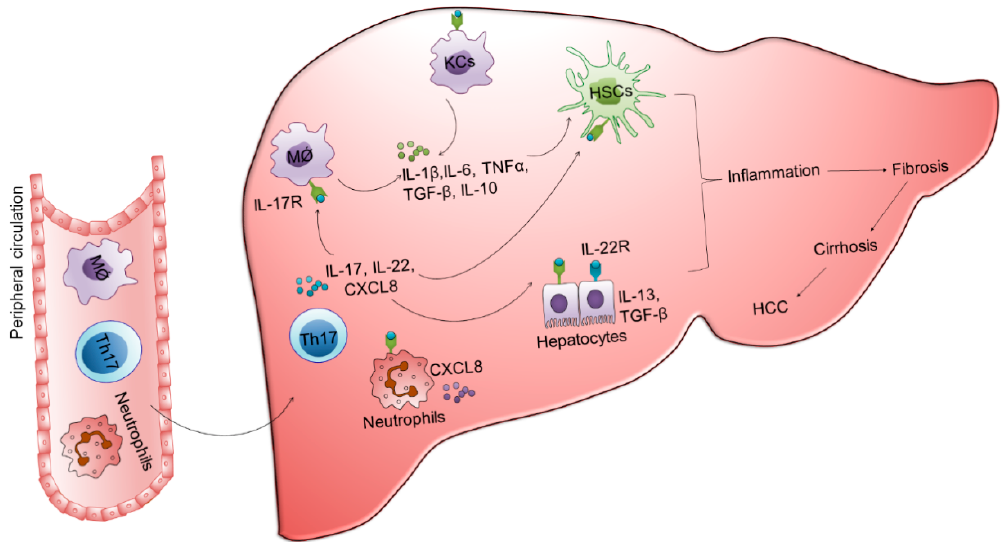
Figure 2. Innate and adaptive immune cells are involved in hepatic inflammation, fibrosis, cirrhosis, and HCC in CHB. Continuous viral exposure prompts the activation of intrahepatic immune cells that initiates the recruitment of circulating immunocytes to the liver. These infiltrated cells stimulate other parenchymal and non-parenchymal cells in the liver. Th17 cells secrete enormous amounts of IL-17 that bind to its receptor present on the surface of many intrahepatic cells and worsen hepatic inflammation by triggering the inflammatory cascade. Induction of profibrogenic mediators IL-10 and TGF- β encourage liver fibrosis by activating hepatic stellate cells. Moreover, continuous supplementation of these fibrogenic stimuli promotes further disease progression towards fibrosis, cirrhosis, and HCC. M Ǿ : Macrophage, Th17: T helper 17, KCs: Kupffer cells, HSCs: Hepatic stellate cells, TNF- α : Tumor necrosis factor- α , TGF- β : Transforming growth factor- β , CXCL8: Chemokine ligand 8, HCC: Hepatocellular carcinoma. Other T helper cell subsets, including Th1 and Th2, are also important players in chronic HBV infection [166]. Naïve T cells differentiate into Th1 cells by early exposure of